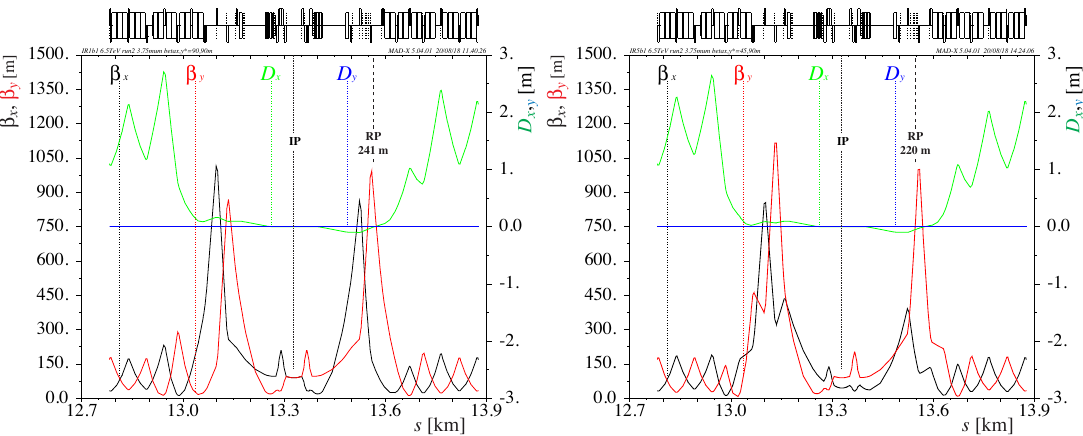
Figure 4. 90/90m optics for ATLAS-ALFA ( left ) and 45/90m optics for TOTEM ( right ). = 90 m is not critical. Instead, separation and crossing angle Aperture at top energy at β ∗ y bumps are limited by the maximum strength available from corrector magnets. The separation and crossing angle bumps were optimized to minimize the maximum magnet strength needed (Figure